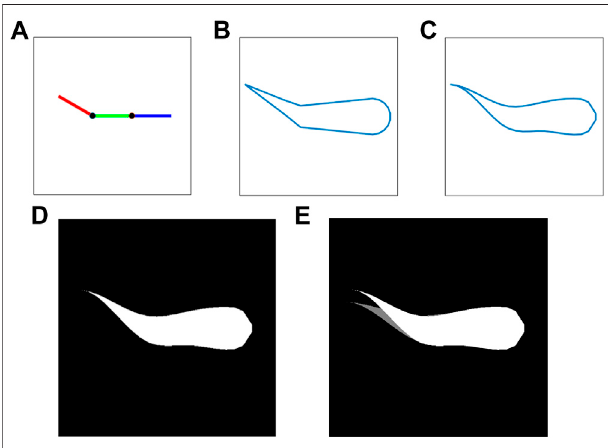
FIGURE 5 | Sequential approach towards generating an image-based observation z p , q ( t ) of a sample soft robotic fi sh pro fi le with ψ j − 30 ° at time t . (A) Geometric plot of 3-link robotic fi sh; (B) generating a perimetric offset around the three links; (C) cubic spline interpolation of the perimetric offset; (D) generated Region of Interest by masking the interpolated closed polygon; (E) inclusion of curvature dynamics [ _ ψ j overlaying previously generated image z p , q ( t − t o ) for a soft robotic fi sh pro fi le with